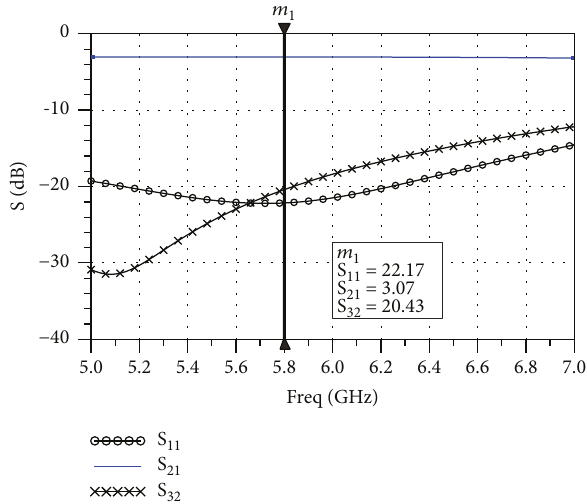
Figure 7: Amplitudes of the scattering parameters of the Wilkinson power divider simulated in ADS schematic with K = 1 and R = 100 Ω .